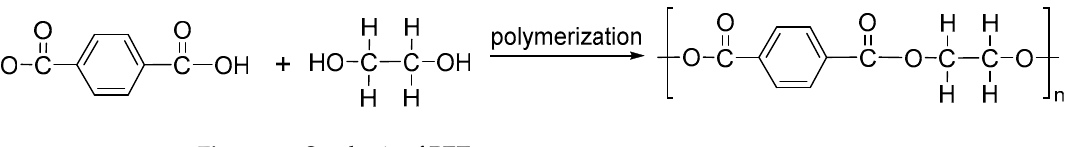
Figure 13. Synthesis of PET.